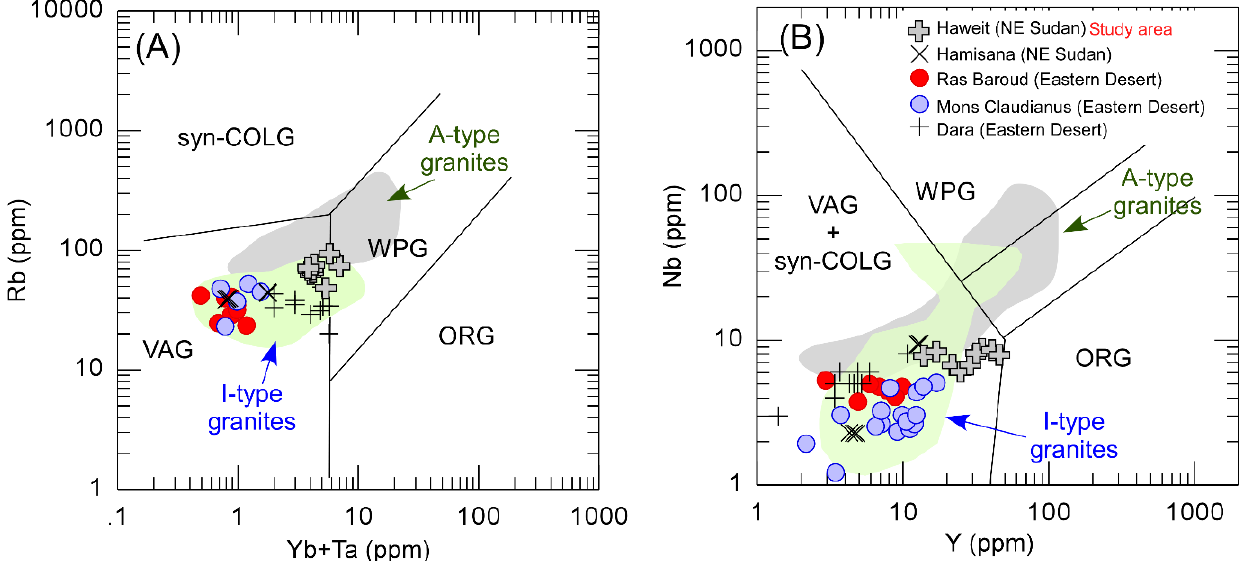
Figure 12. ( A ) Rb vs. Y + Ta [72] and ( B ) Nb vs. Y [73] tectonic discrimination diagrams for the Haweit granodiorite. VAG: volcanic arc granites; ORG: ocean ridge granites; WPG: within plate granites; syn ‐ COLG: syn ‐ collision granites. The fields of A ‐ type and I ‐ type granites from the ANS are adopted from Robinson et al. [65,66].